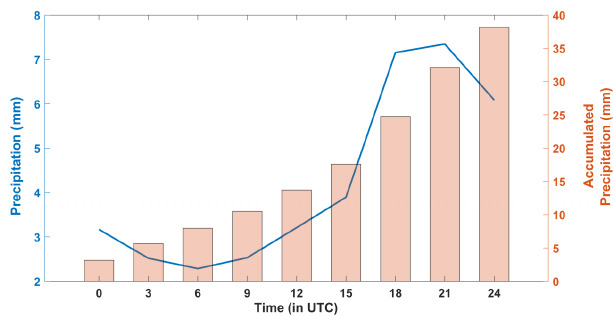
Figure 5. Domain-averaged 3h precipitation on the day of occur- rence of a high precipitation event averaged for all events. The ac- cumulated precipitation values are given in the background as